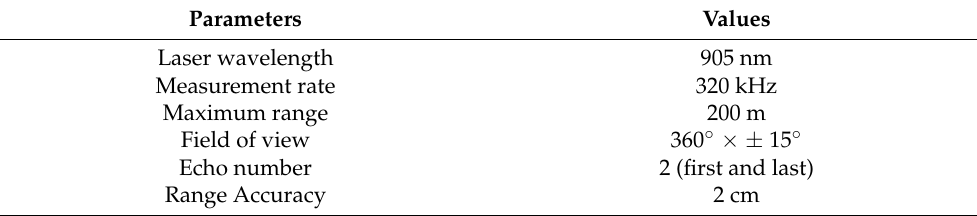
Figure 2. UAV platform: ( a ) DJI Matrice 600 Pro with Genius LiDAR system; ( b ) DJI Phantom 4 Pro. Table 1. LiDAR system parameters.